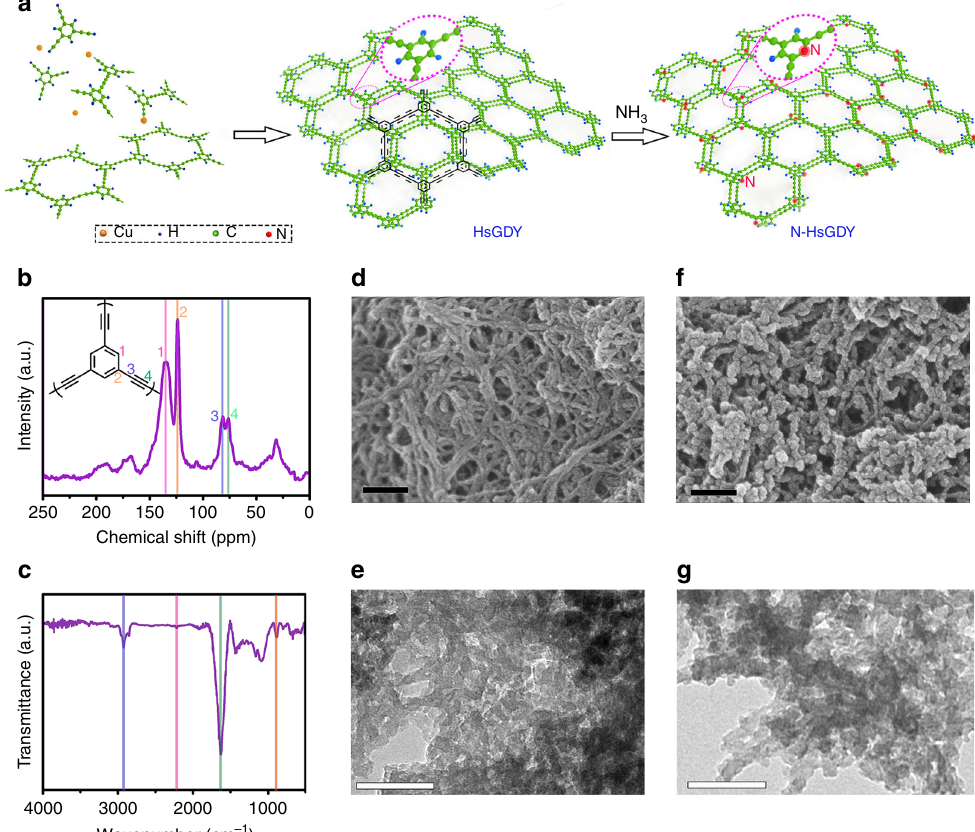
Fig. 1 Preparation and characterization of hydrogen-substituted graphdiyne-based materials. a Schematic illustration of the preparation process for the hydrogen-substituted graphdiyne (HsGDY) from the monomer triethynylbenzene. Triethynylbenzene molecules are polymerized to generate HsGDY through a cross-coupling reaction with copper ion as catalyst. The HsGDY is pyrolyzed in an ammonia (NH 3 ) atmosphere to produce pyridinic nitrogen- doped hydrogen-substituted graphdiyne (N-HsGDY). For clarity, HsGDY and N-HsGDY are shown with only two layers. b 13 C solid-state NMR spectrum for HsGDY; the insert displays the structure of the monomer of HsGDY. c Fourier transform infrared spectrum of the HsGDY, d scanning electron microscopy (SEM) and e transmission electron microscopy (TEM) images of HsGDY. f SEM and g TEM images of N-HsGDY-900 °C. Scale bar, 100 nm for d –